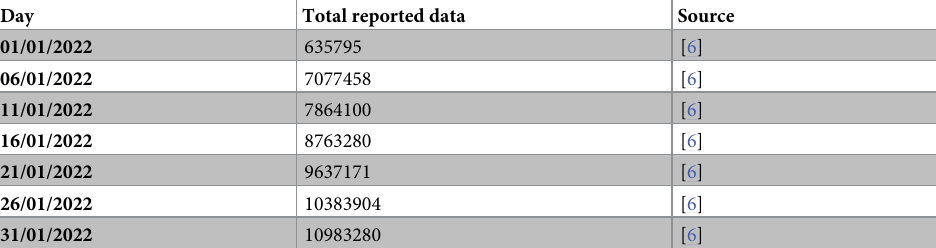
Table 4. The number of Infected cases in Italy, from 1 st January 2022 to 31 st January 2022.